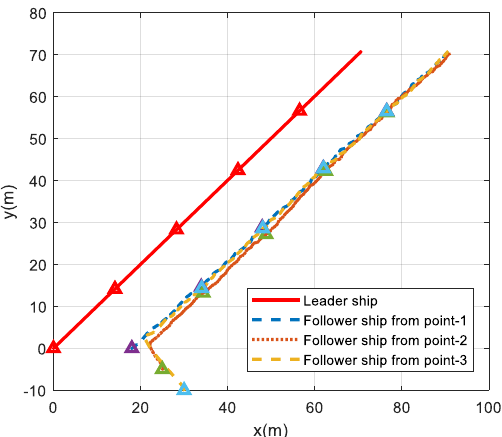
Figure 2. The tracking performance of the synchronization control from disparate initial points with disturbances.